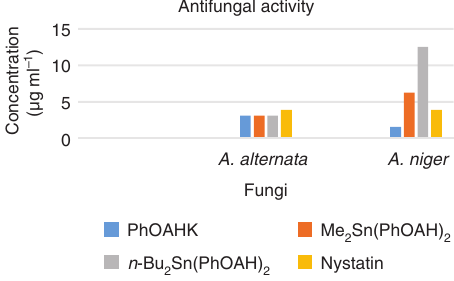
Figure 5: In vitro antifungal